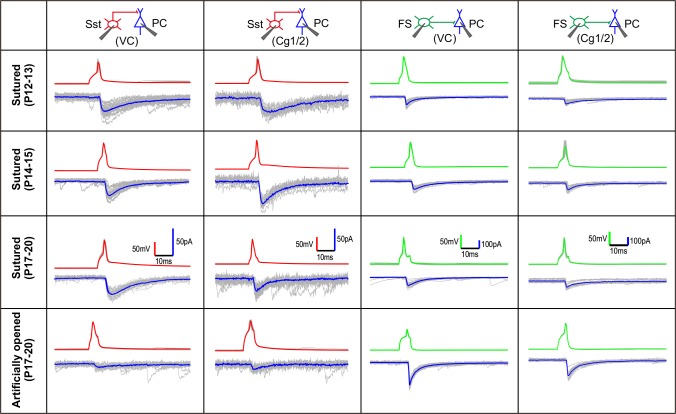
Representative traces of synaptic transmission (related to Figure 6).Top panels indicate the direction of synaptic transmission.